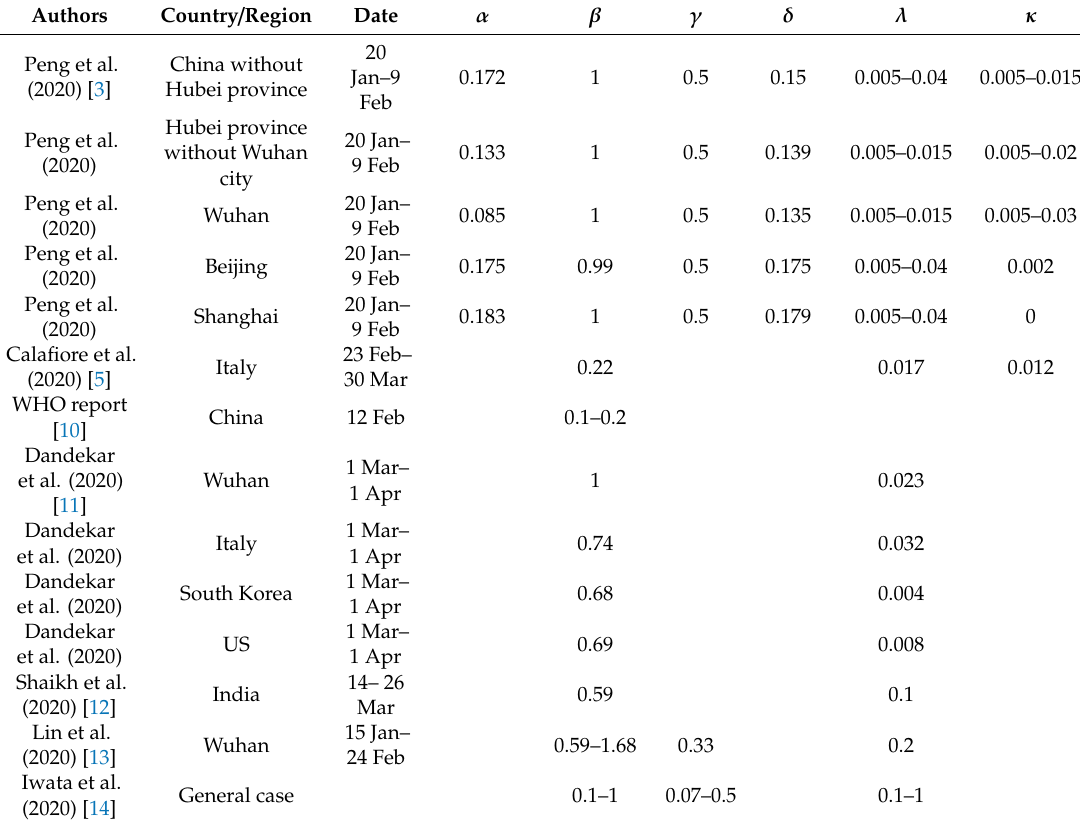
Table 2. Values of α , β , γ , δ , λ , and κ describing SARS-CoV-2 outbreak in the recent